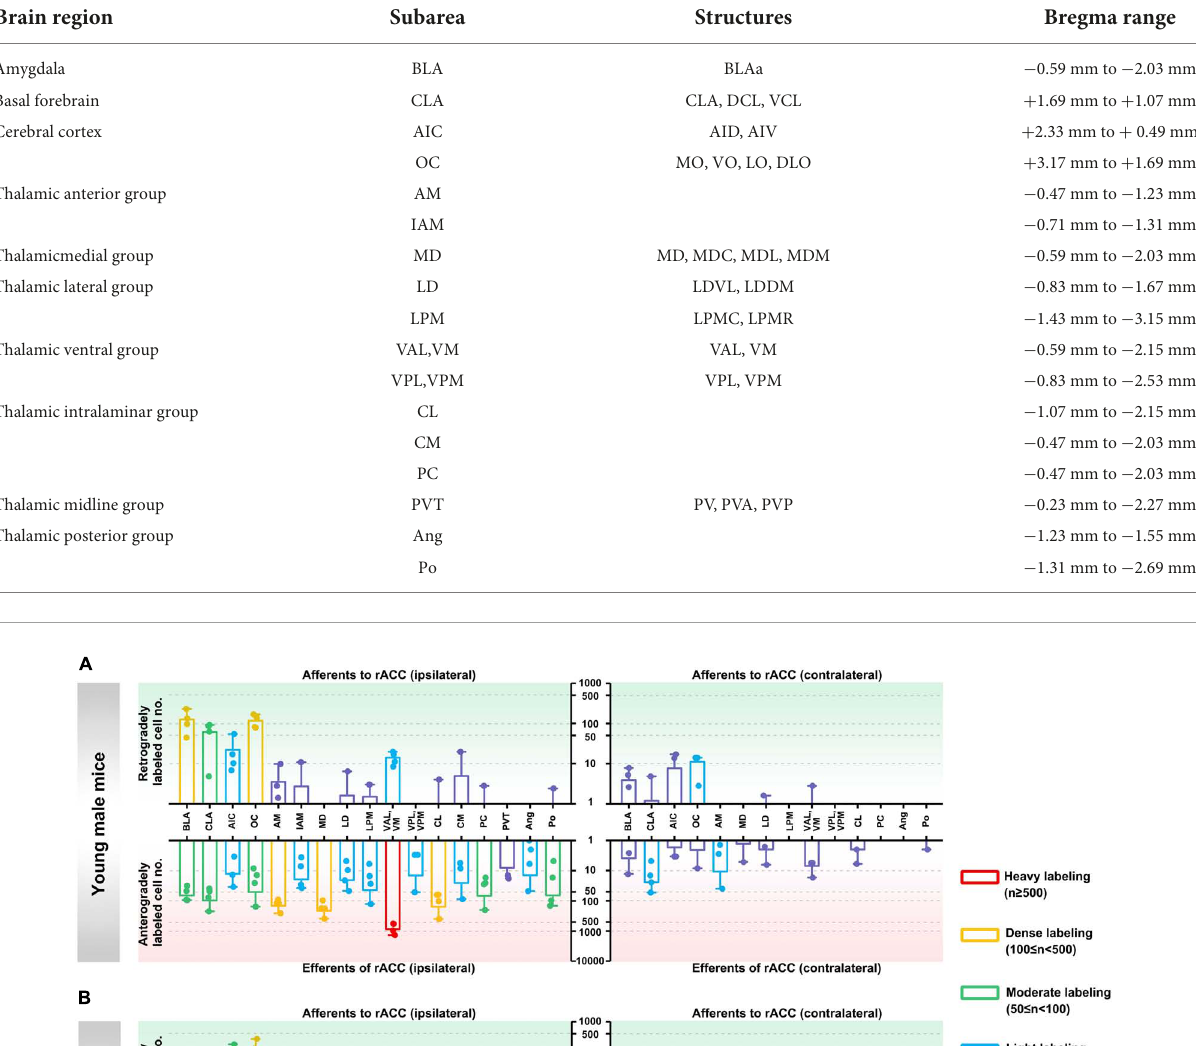
TABLE 1 Brain region classification.